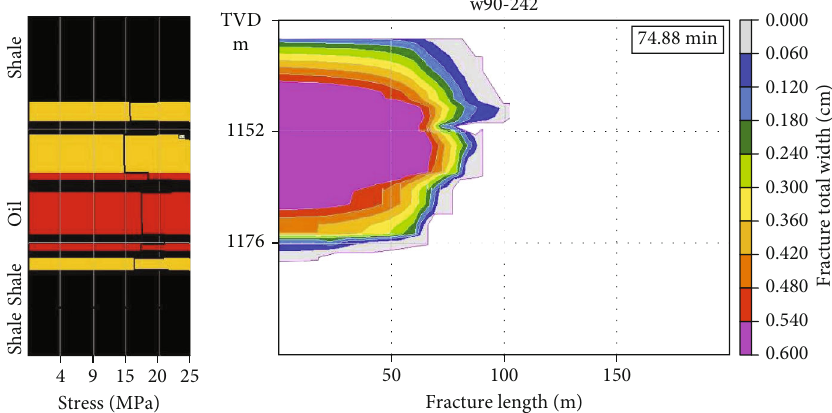
Figure 5: Simulation results of well W90-242 under fi xed-plane perforation fracturing.